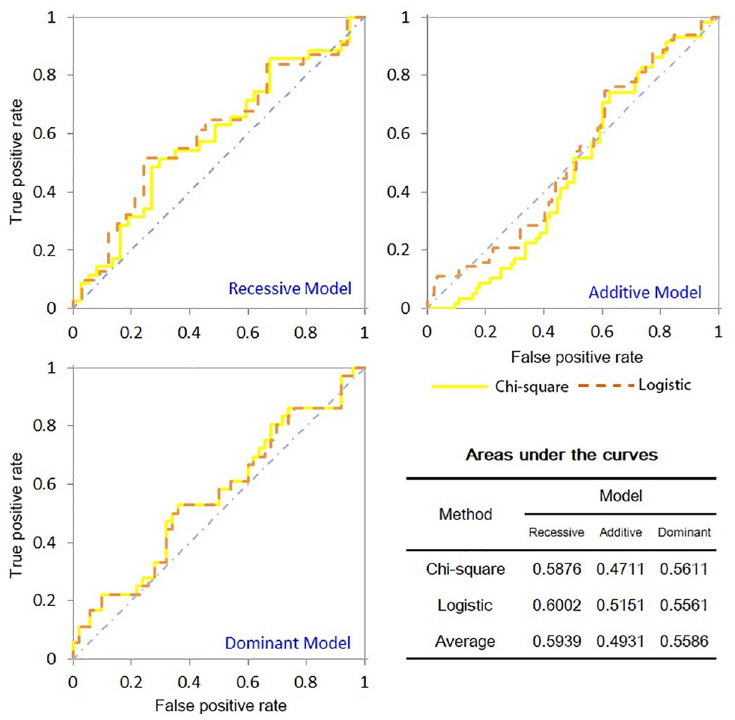
Fig 2. Receiver operating characteristic curves and areas under the curves on real